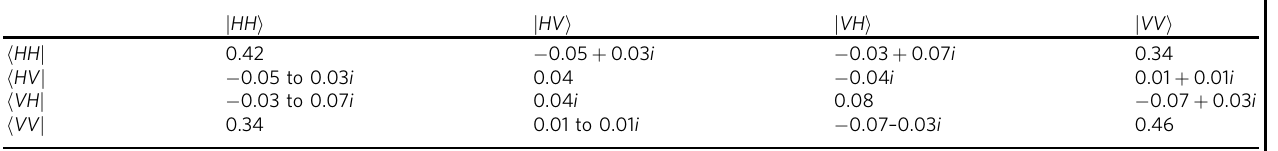
Table 1 The elements of the density matrix without QFC